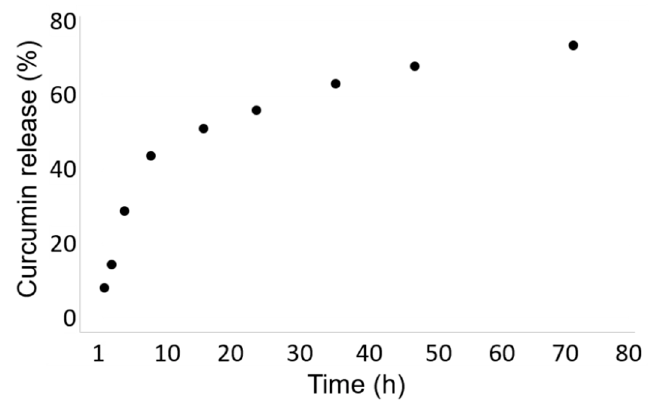
Figure 7. In Vitro Curcumin Release Study.